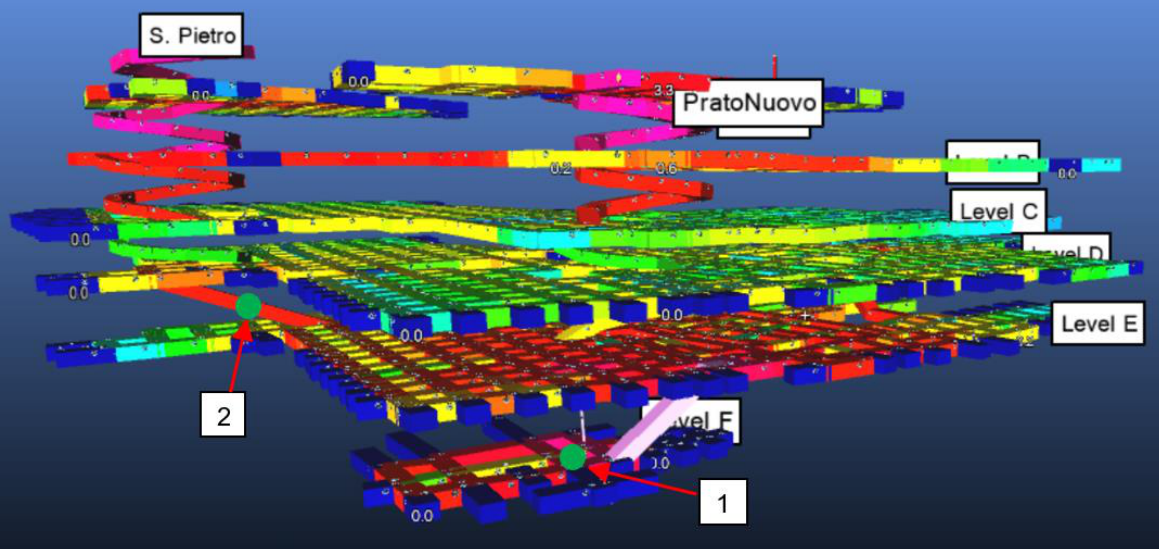
Figure 3. View of the numerical model developed to study the effect of fires inside the Murisengo underground quarry (Case A: current situation). The different levels (from A to F), the main helical ramps (S. Pietro and Prato Nuovo), the connecting ramp between Levels E and F (E – F ramp), and the shaft with the main fan of the mine. The two areas where the fire was hypothesized (green points) are also shown: (1) at Level F and (2) on the connecting ramp between Levels D and E.